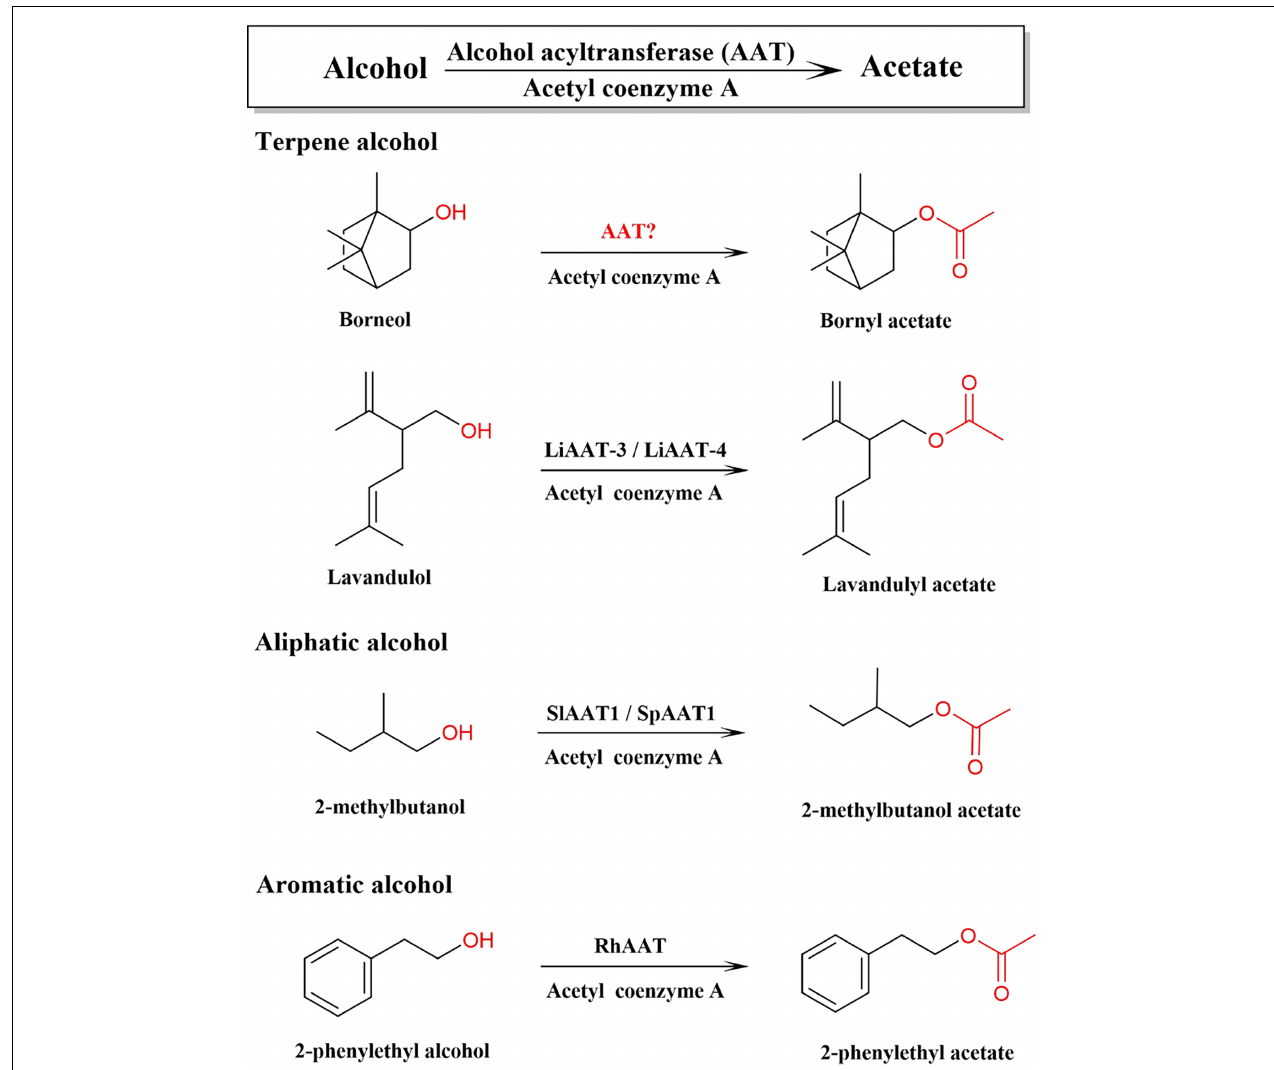
FIGURE 1 | Alcohol acetyltransferase (AATs) involved in the biosynthetic pathway of acetate with different precursor alcohols.